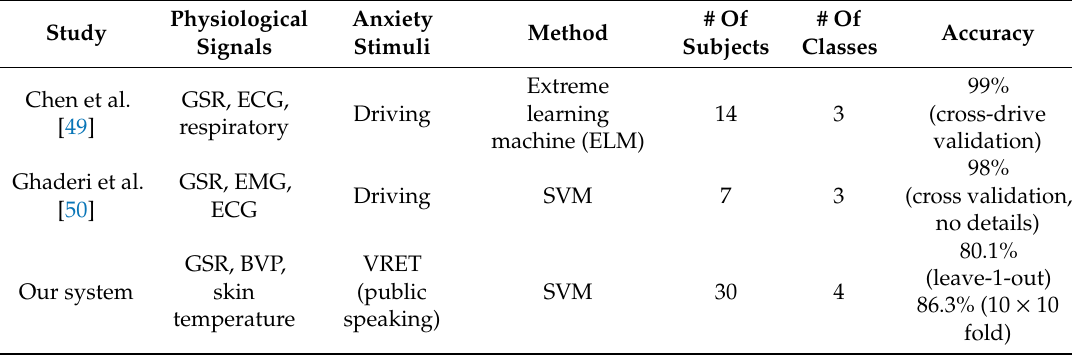
Table 5. Comparison with driving-induced stress recognition systems.